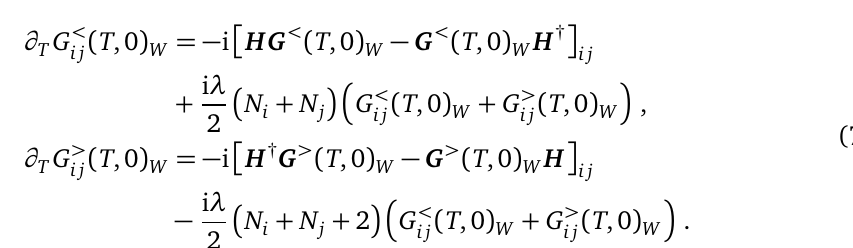
( t , t (cid:48) ) for the open Bose dimer described by Eq. (65), with 11 = 0.0, J = λπ/ 4, N 2 δ ( 0,0 ) = − i δ , G > i 2 j 2 ij